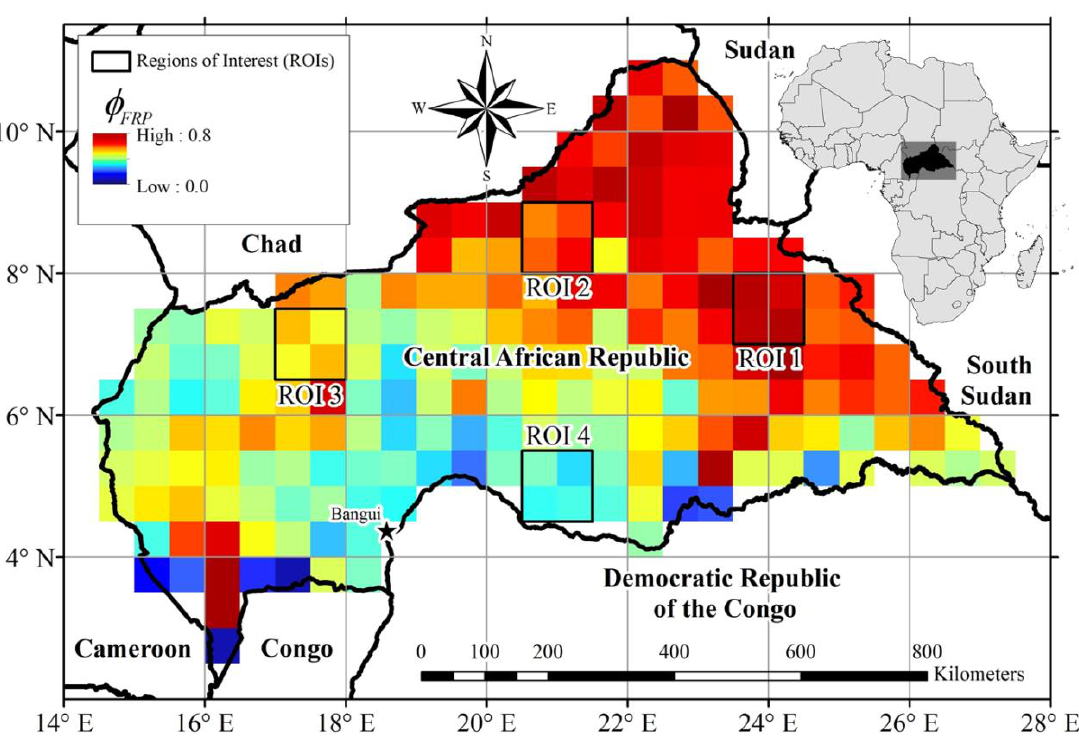
Figure 3. Seasonal SEVIRI-to-MODIS ratios of summed fire radiative power (FRP) concurrently measured by both sensors, ϕ , mapped at 0.5° grid cell resolution. The FRP performance of the Fire Thermal Anomaly (FTA) detection algorithm is evaluated in four 1.0° regions of interest (ROIs) subjectively located (i) to span the widest possible range of ϕ across the CAR; and (ii) to circumscribe relatively homogeneous values of ϕ FRP FRP